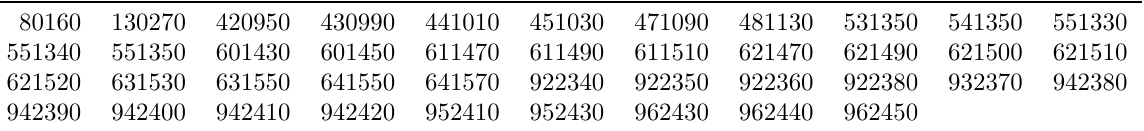
Table 1. List of 42 considered nuclides that are passed on between subsequent computation steps (ZAI numbers [4]).